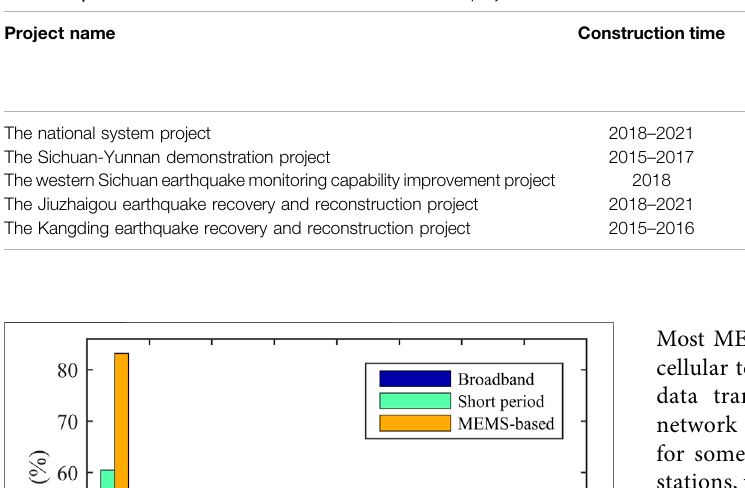
Frontiers in Earth Science |